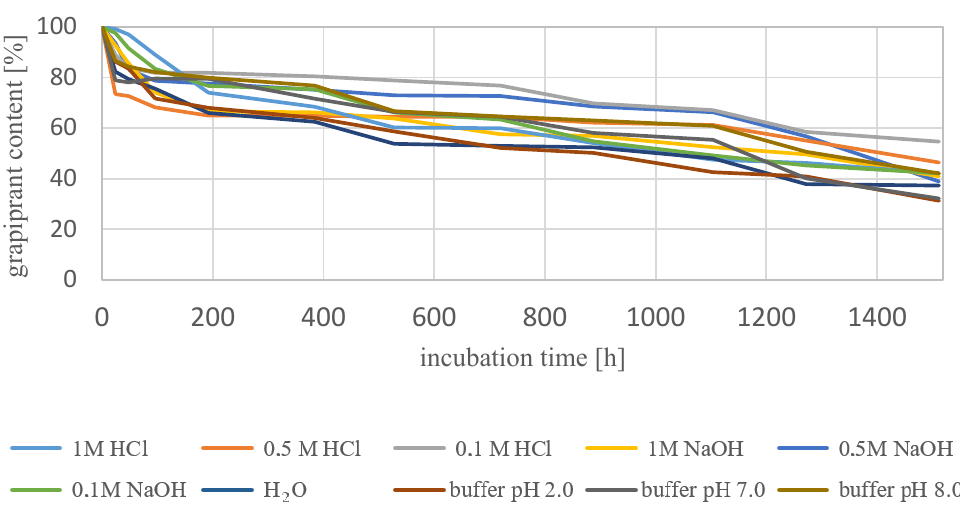
S2 and shown in Figure 7. Figure 6. Percentage of grapiprant content during degradation at room temperature as pH function.